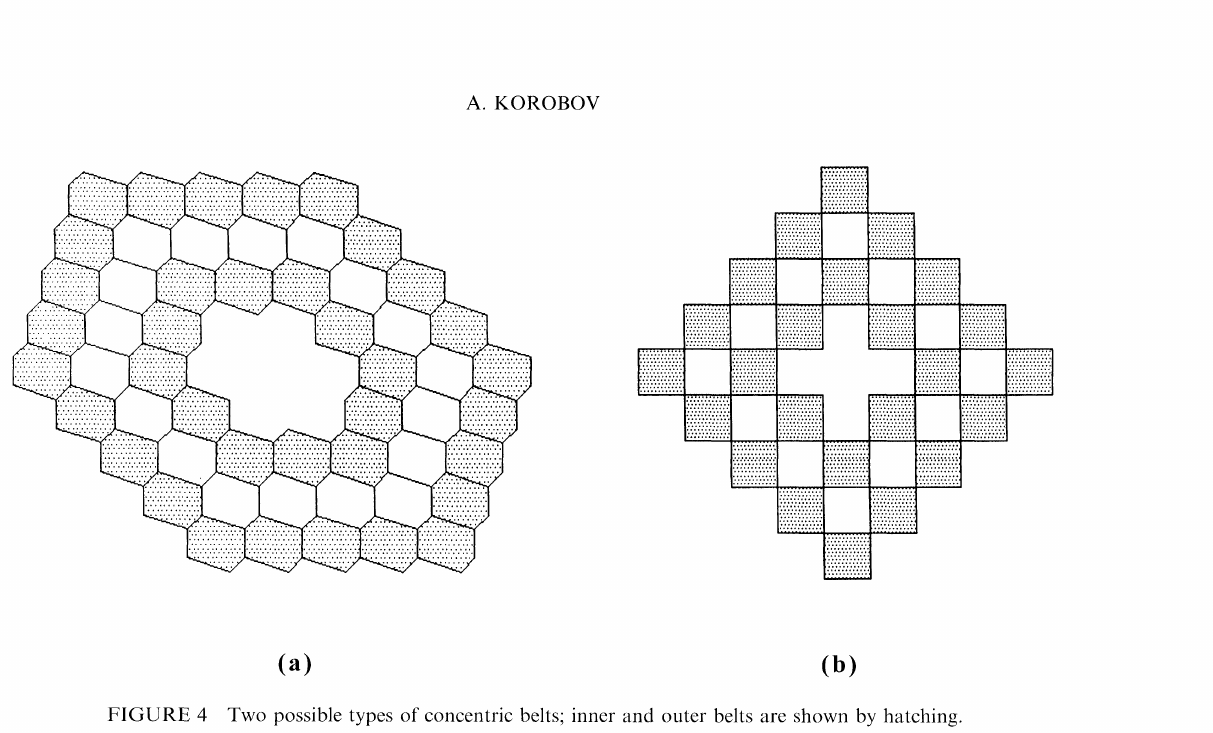
FIGURE 4 Two possible types of concentric belts; inner and outer belts are shown by